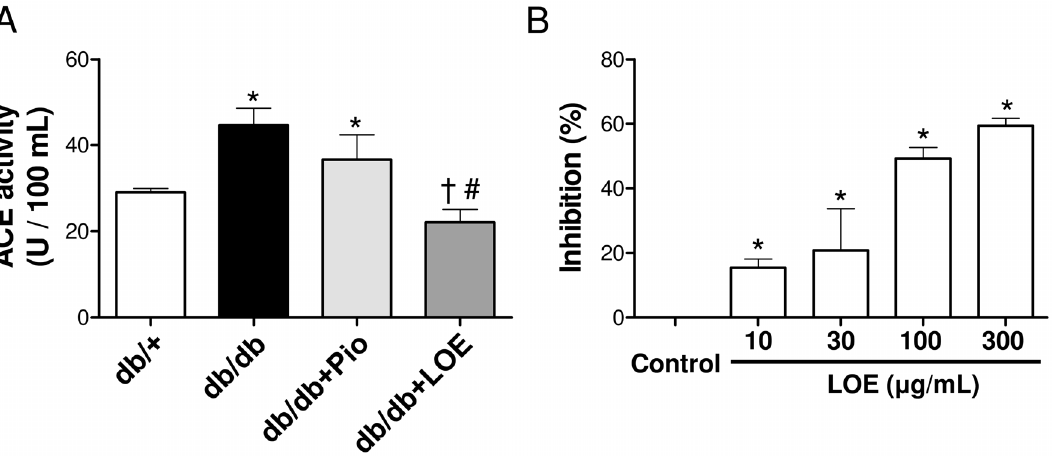
Figure 6. LOE reduces plasma angiotensin converting enzyme (ACE) activity in db/db mice (A), and inhibits the activity of purified ACE (B). Values are shown as means 6 S.E.M. n=6–7 (A) and 3 (B). * P , 0.05 indicates a significant difference between db/ + group versus db/db group, db/db + Pio group or db/db + LOE group, { db/db group versus db/db + Pio group or db/db + LOE group, and # db/db + Pio group versus db/ db + LOE